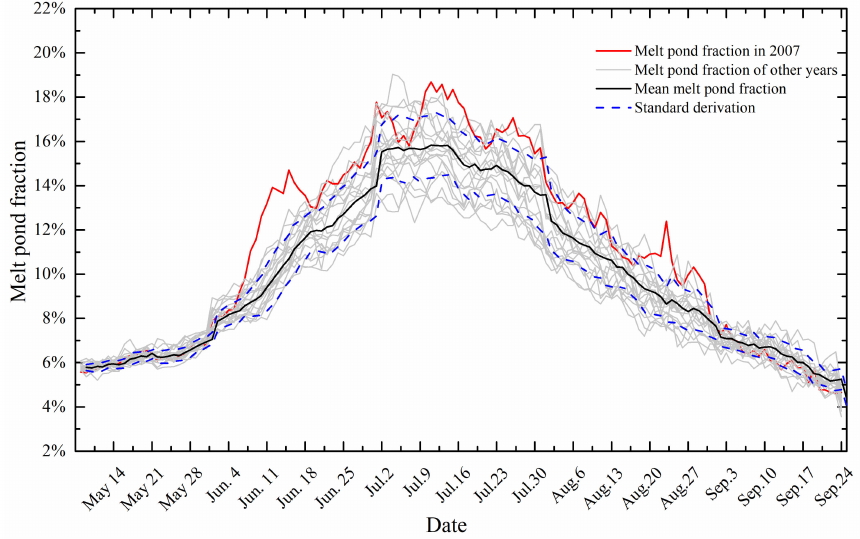
Figure 18. Temporal variations in the MPF of the Arctic sea ice derived from the NENU-MPF datasets from 2000 to 2020. The pixels over the entire Arctic sea ice region were